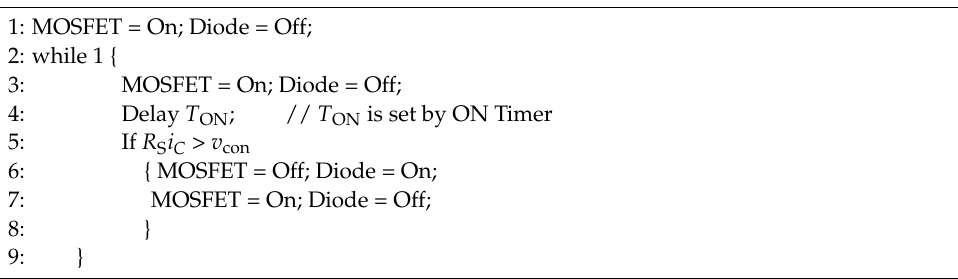
Figure 2. Schematic diagram of the CC-COT-controlled buck converter. Algorithm 1: The Workflow of the CC-COT